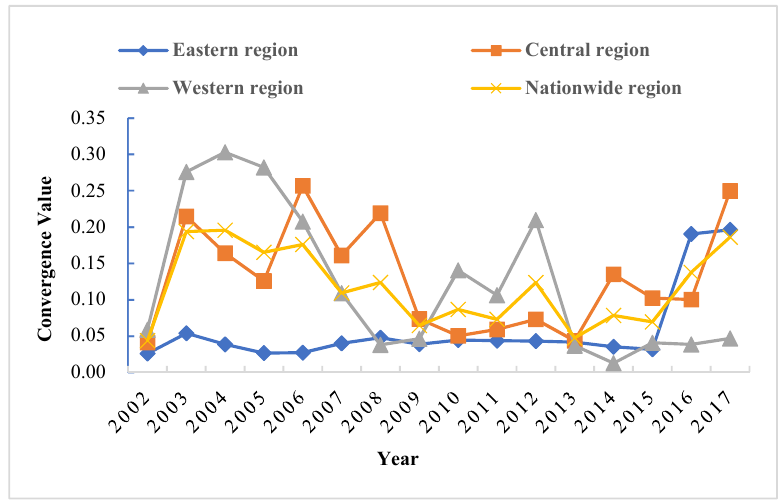
Figure 8. Evolution of σ convergence across the country and in the eastern, central, and western regions.